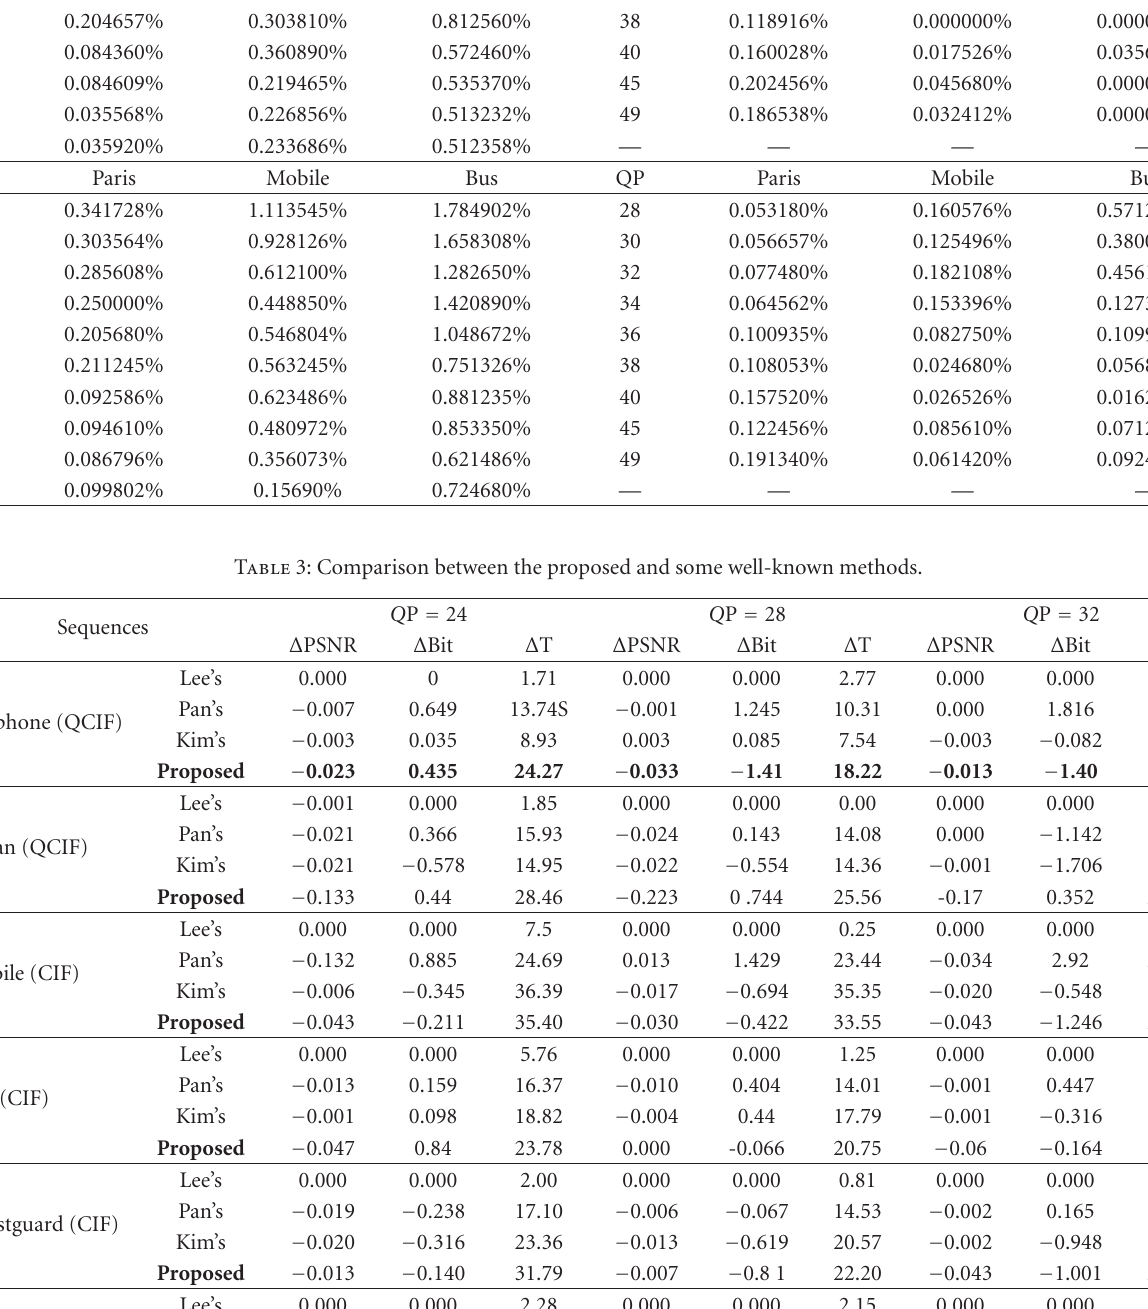
Table 2: Percentage of missing blocks that should have passed intra-mode prediction.